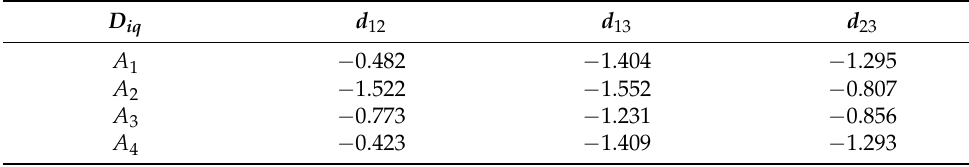
Table 9. The value of D iq with respect to LDAR i